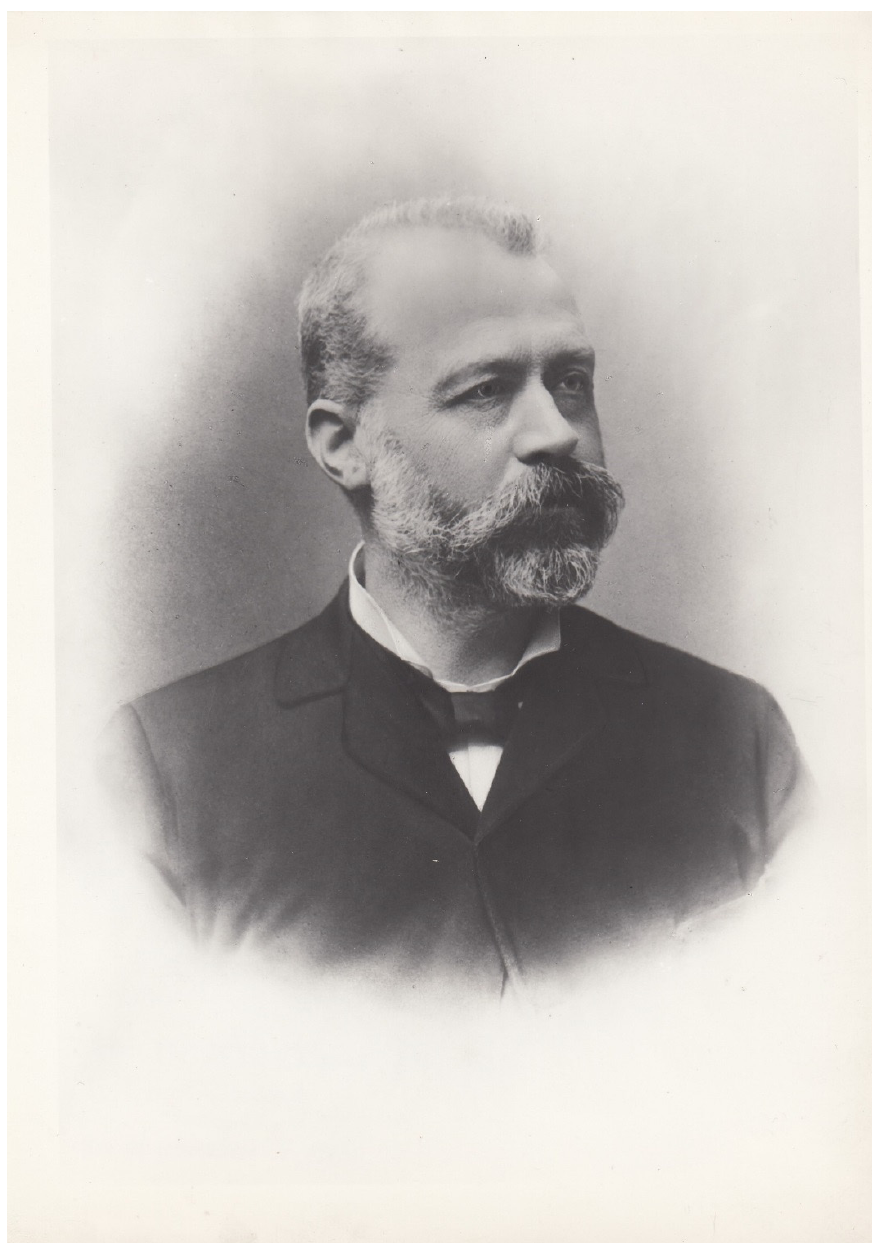
Figure 1. Carlo Forlanini. University Museum System, University of Pavia, Italy.